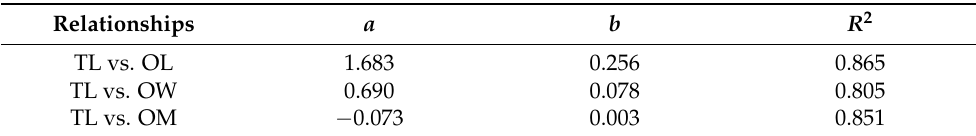
Table 3. Parameters of the linear regression between fish total length (TL) and otolith morphometrics (OL = otolith length, OW = otolith width, OM = otolith mass) of the European barracuda, Sphyraena sphyraena , in the eastern Adriatic ( a = intercept value; b = regression slope; R 2 = coefficient of determination).